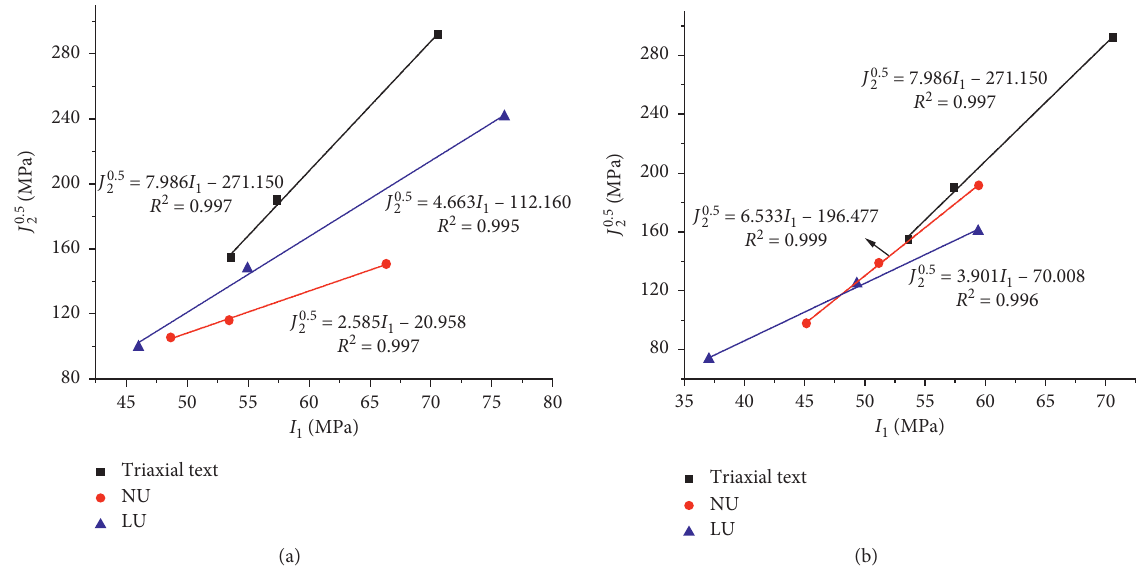
Figure 17: Strength criterion based on elastic strain energy: (a) V